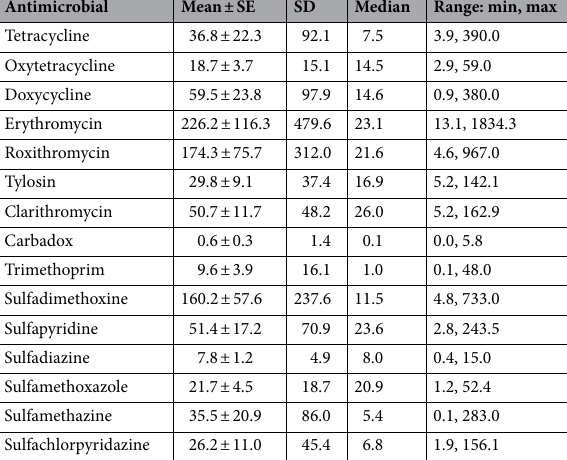
Table 3. Summary statistics (arithmetic mean ± standard error, standard deviation (SD), median, and range: minimum (min) and maximum (max)) for antimicrobial concentrations analyzed in sediment samples (ng/g) across sites in 2019 (n =